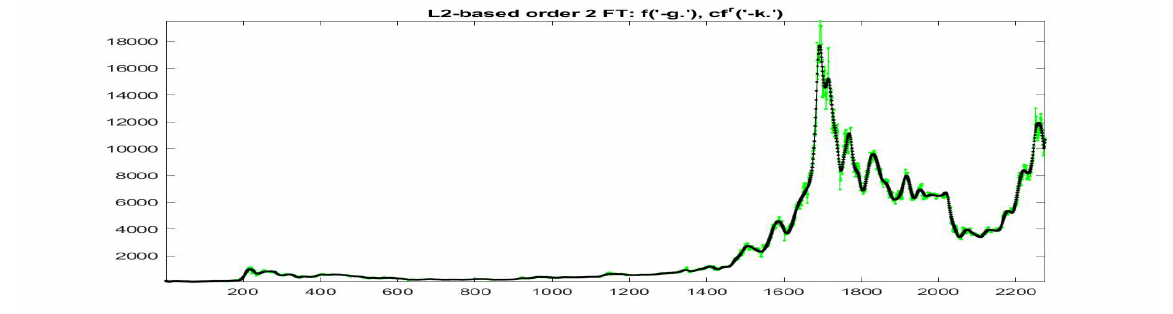
Figure 27. L 2 -norm modified iF-transform values f q fuzzy r -partition is P b with r = 3.